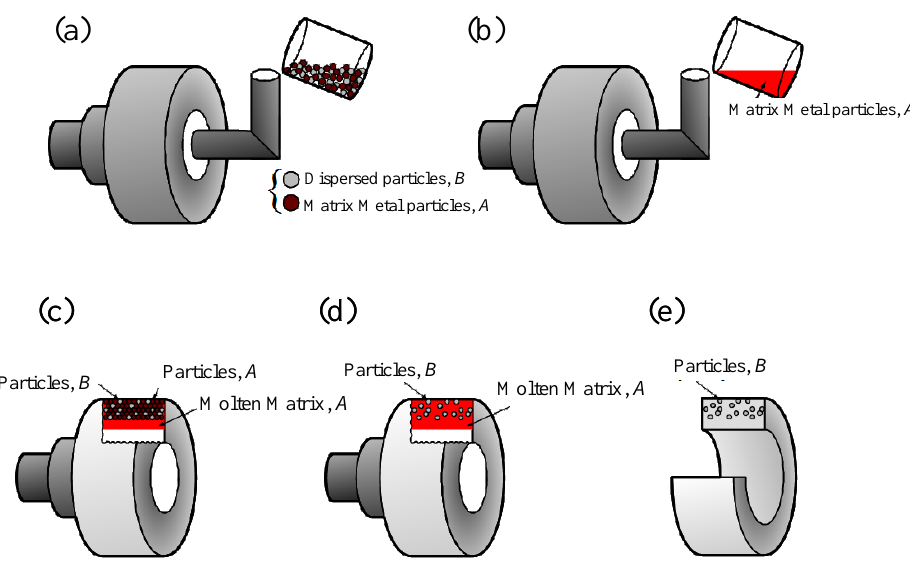
Figure 4. The schematic description of CSPM